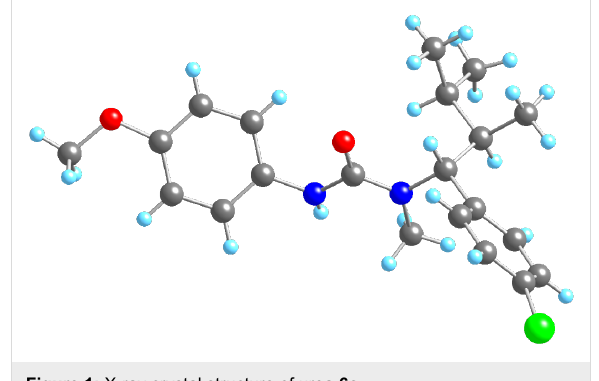
Figure 1: X-ray crystal structure of urea 6c